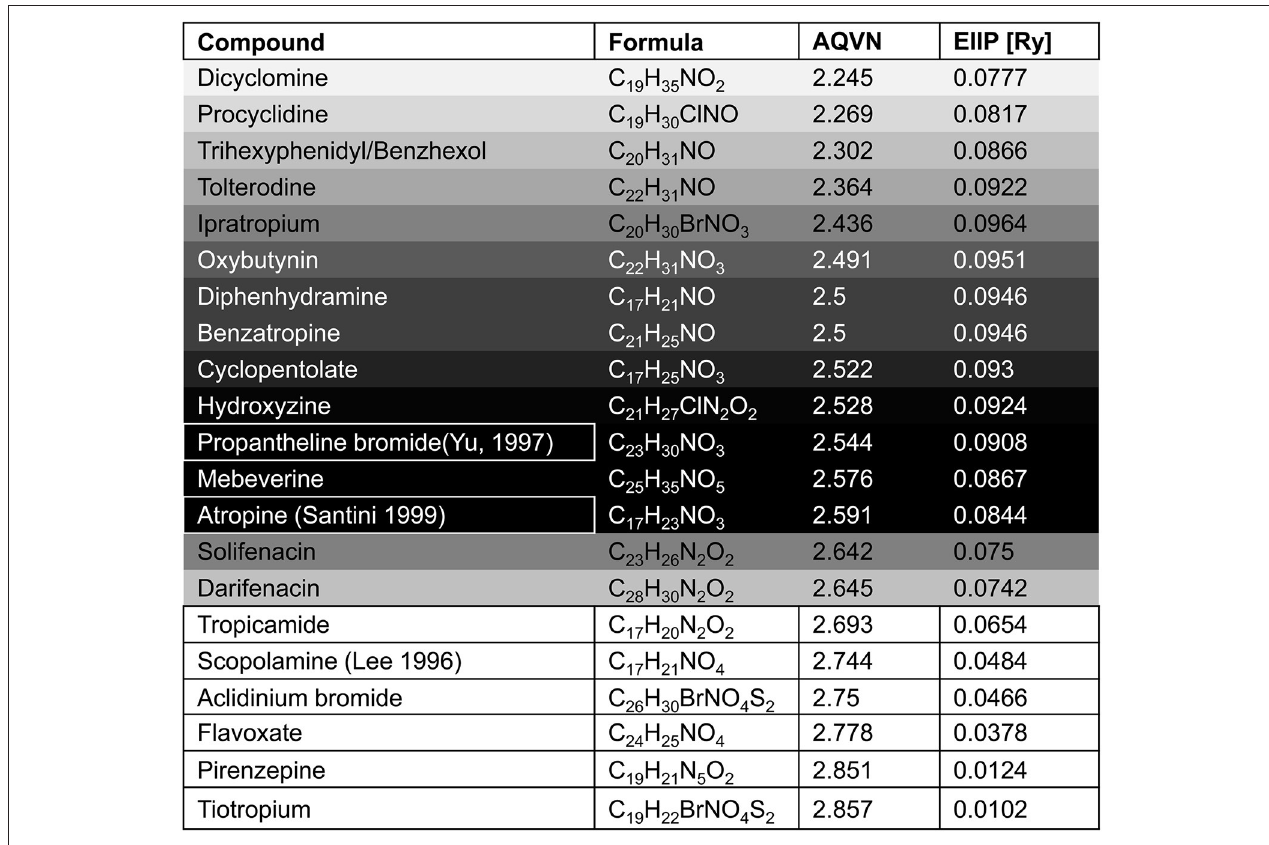
FIGURE 5 | The list of antimuscarinic drugs tested for their AQVN/EIIP. Shaded fields- antimuscarinic drugs within the active domain ( Figure 3 ), white fields-antimuscarinic drugs out of the active domain, bordered fields- antimuscarinic drugs tested for their therapeutical effect on VVS. Probability for the anti VVS activity of muscarinicdrugs, assessed by EIIP/AQVN criterion, is represented with the gray scale (black-the highest probability, white-the lowest probability).